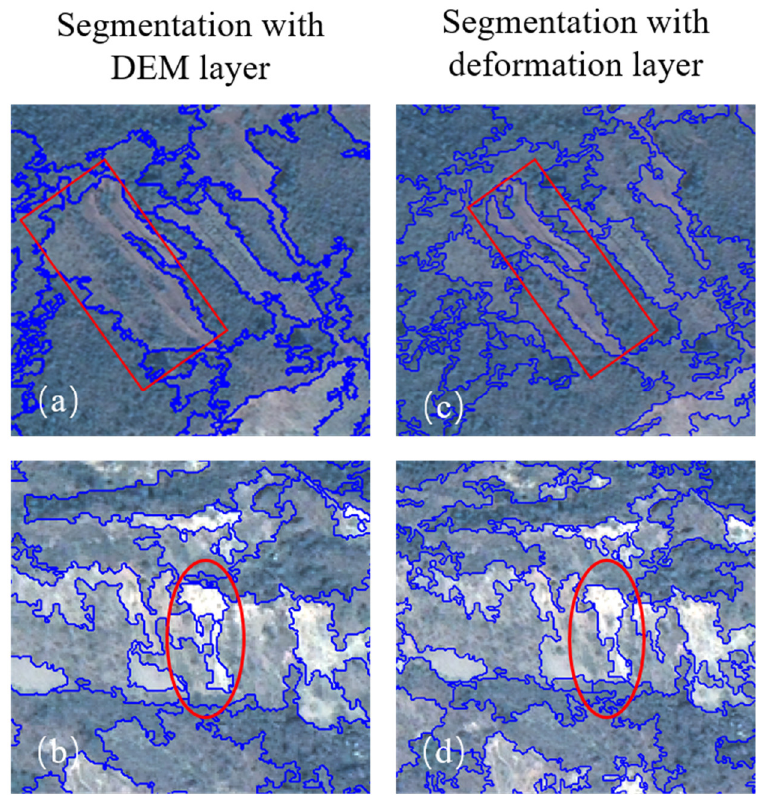
Figure 10. Details of the segmentation results: ( a , b ) represent the result derived from the multispectral layers and DEM layer; ( c , d ) represent the result derived from the multispectral layers and deformation layer. The red rectangle and circle indicate the comparison of the details of the two results.